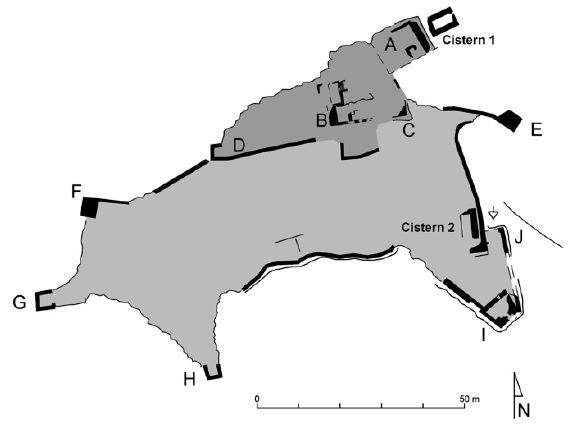
Figure 1. Layout drawing of the castle.